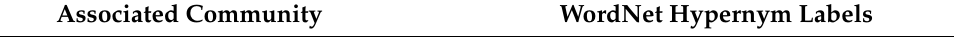
Table 8. Best-ranked WordNet hypernym labels for associated communities FoF [ and | or ] ljutnja source lexeme ljutnja-n in Croatian hrWac corpus extracted through the F [ hyper ]